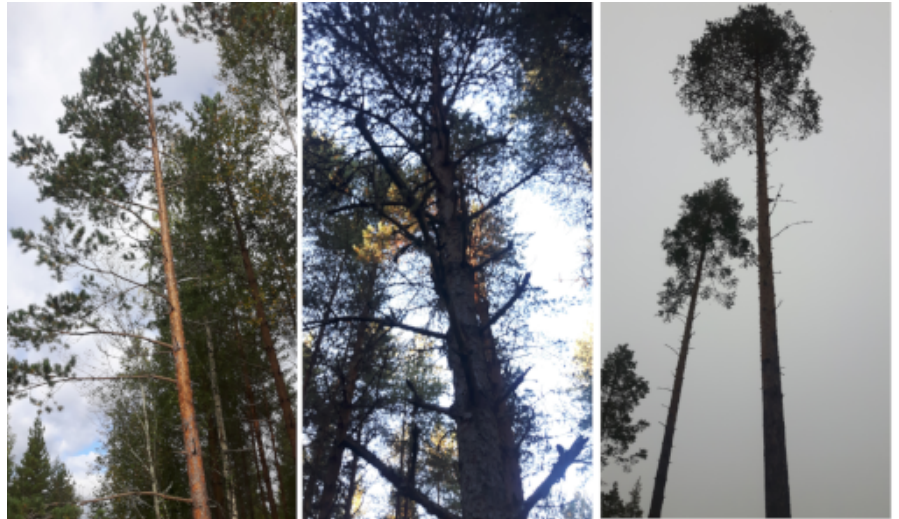
Figure 1. Examples of young and old sample trees with different branching patterns. ( Left ) Pine tree from a stand of age 37 years. ( Middle ) Pine from a stand of age 50 years, with thick branches from ground to tree top. ( Right ) Pines from a stand of age 108 years. A large part of the stems only have small branches. The tree crowns at the top have thicker